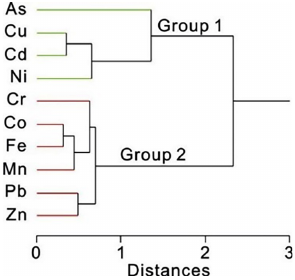
Figure 2. Dendrogram of R-mode cluster